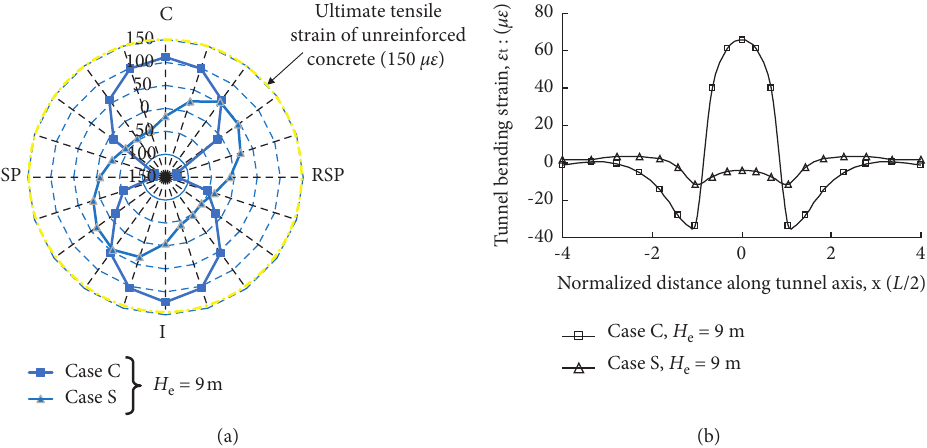
Figure 4: Additional tunnel bending strain. (a) At tunnel transverse section (section C-C). (b) Along the tunnel axis for two cases.